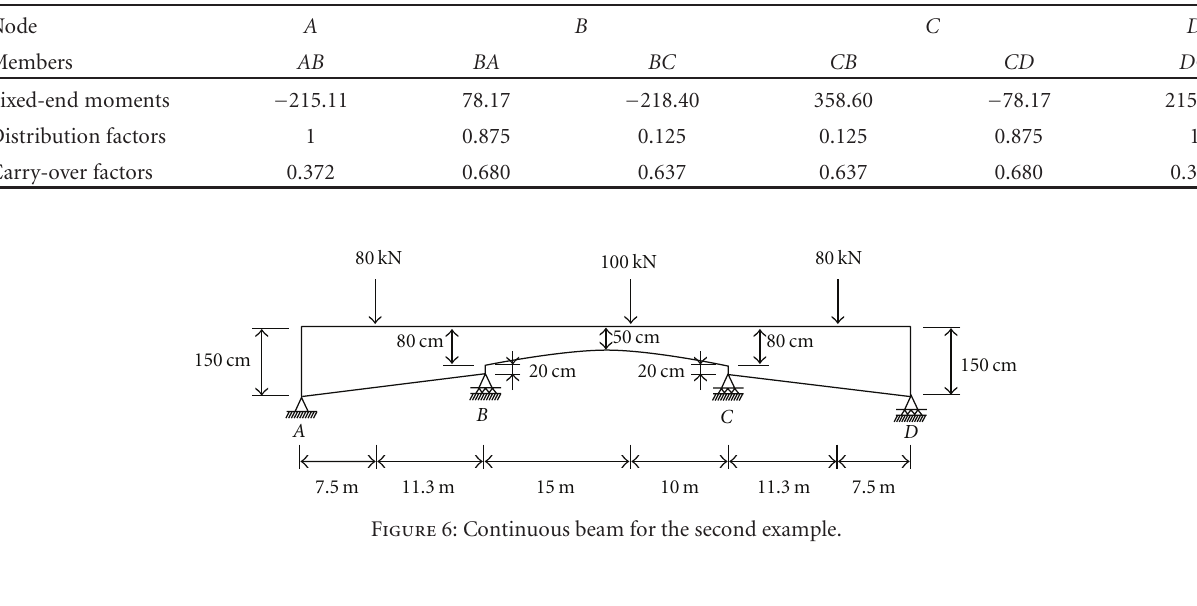
Table 2: Initial moments at the ends of the members and the distribution and carry-over factors for the second example.